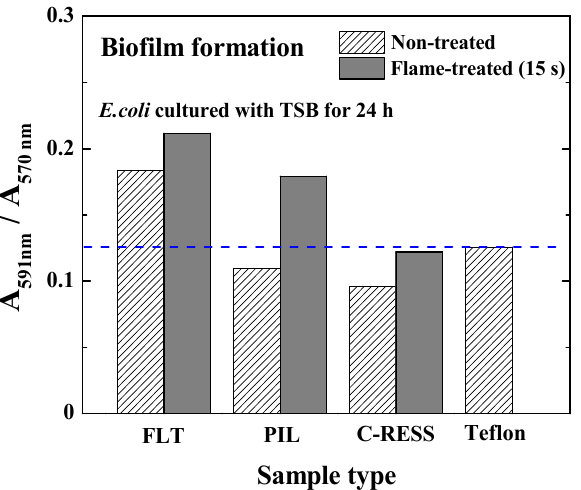
Figure 10. Micro-structures and flame treatment process affect the relative biofilm mass accumulation from the static biofilm formation per surface area ( ≈ 3.238 cm 2 ). Note that the E. coli was cultured with TSB medium for 24 h.